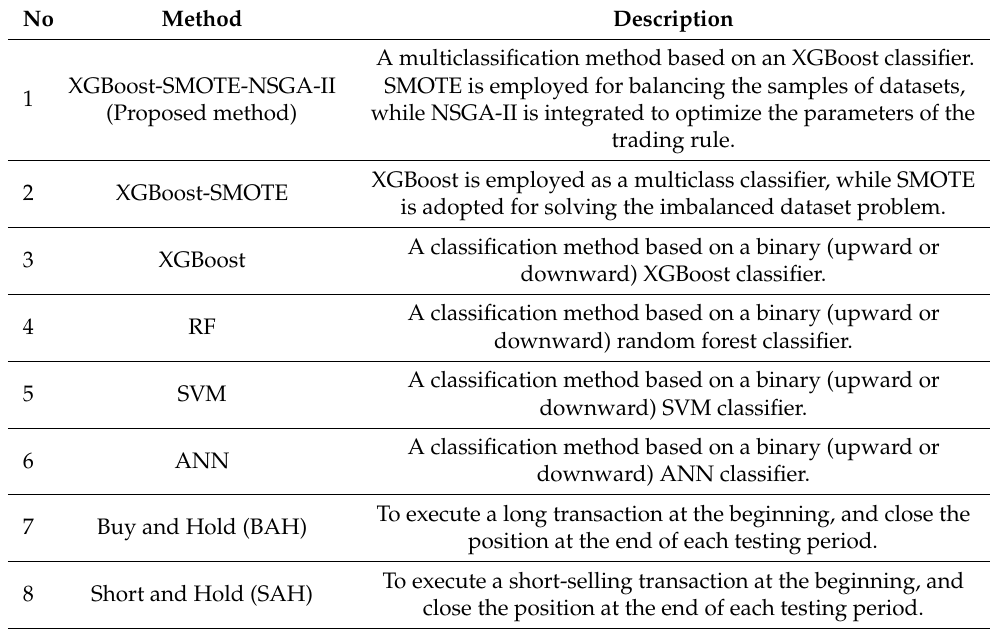
Table 3. A list of the proposed approach and benchmark approaches in the experiments.